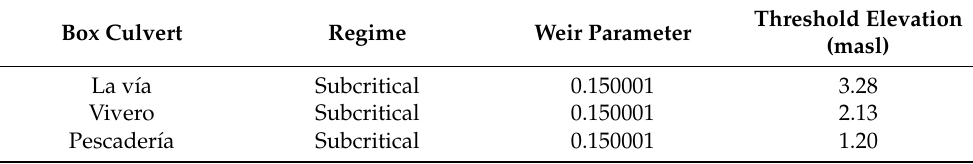
Table 2. Parameters defining the equivalent box culverts in